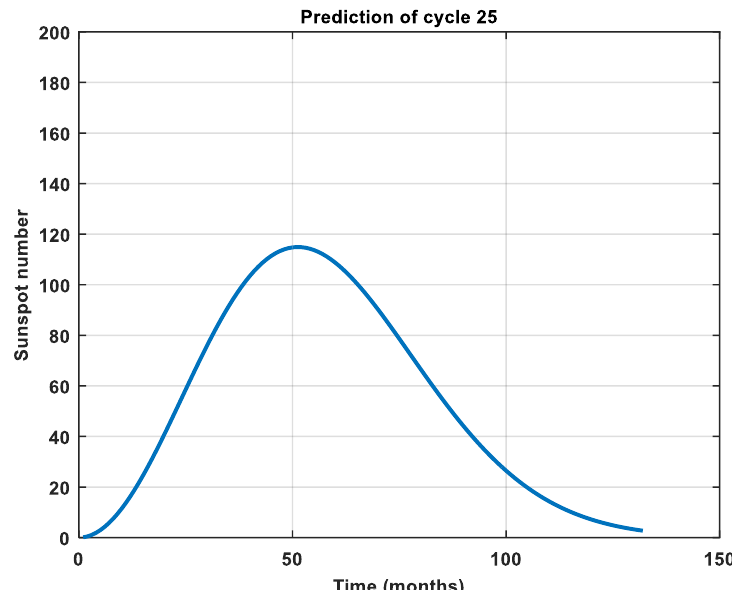
Figure-8. Preliminary level prediction of sunspot cycle 25